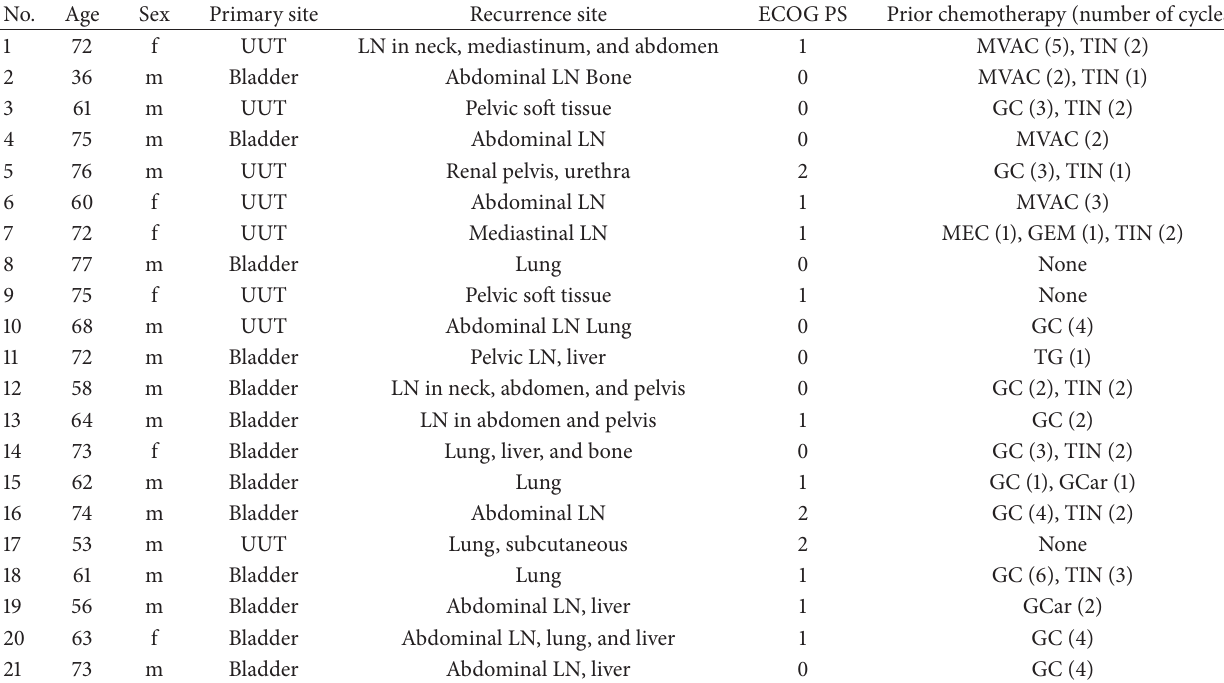
Table 1: Profiles of patients with advanced urothelial cancer enrolled in Study